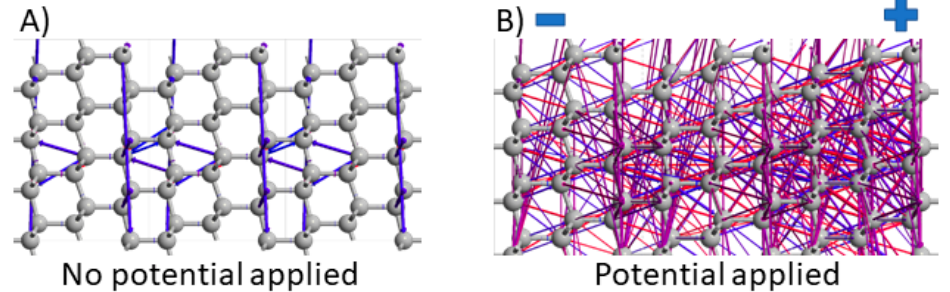
Figure 3. Electron pathways in bulk diamond: ( A ) structure without any external potential across the structure. ( B ) Structure with applied 1V potential across the structure, where on the left side is − 0.5V ( − ), right side 0.5V ( + ). The 2-terminal device structure was used (attn. electrodes are not shown here for figure readability).